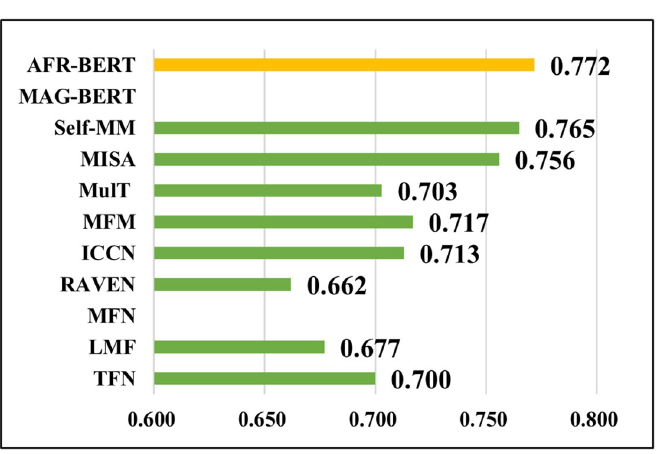
Fig 6. Cross-sectional histograms of Corr metrics for each model on the CMU-MOSEI dataset.